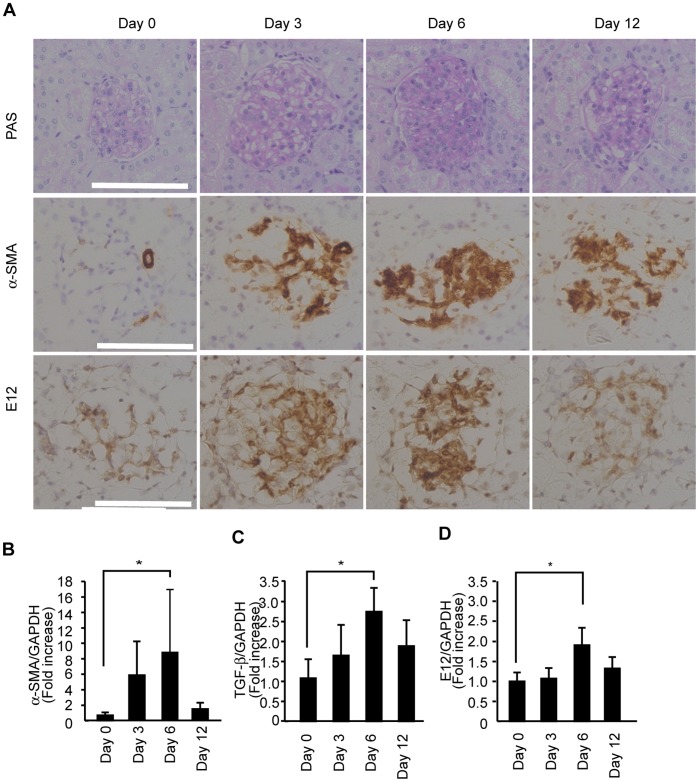
Glomerular expression of E12, α-SMA, and TGF-β in Thy1 GN.(A) Representative light microscopic pictures of glomeruli (periodic acid-Schiff staining) and expression of α-SMA and E12 at day 0, 3, 6 and 12 in Thy1 GN. Significant proliferation of MCs was observed at day 6. (B, C and D) Gene expression of E12, α-SMA, and TGF-β was examined by quantitative RT-PCR using glomerular mRNA. The results were presented as the fold increase compared with the values obtained before the induction of Thy1 GN (day 0). GAPDH, glyceraldehyde-3-phosphate dehydrogenase. *P<0.05, v.s. control. White scale bar = 100 µm. Original magnifications, ×400.